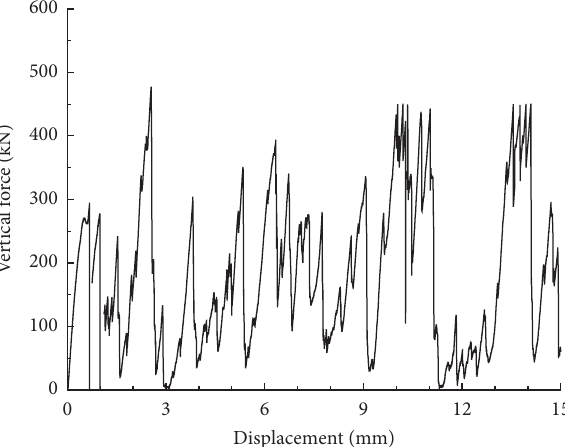
Figure 3: Vertical force in the rock-breaking process of disc